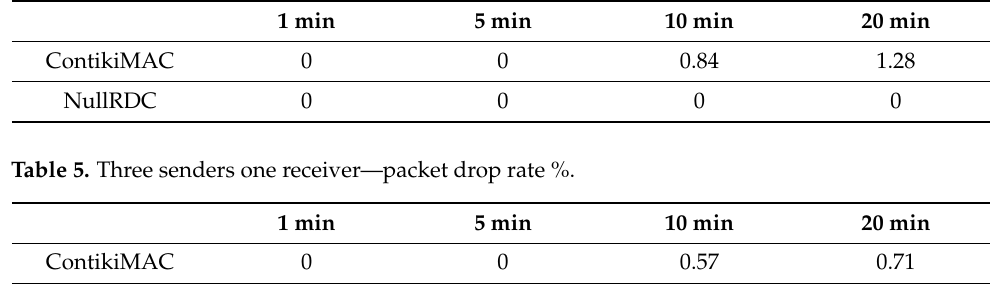
Table 4. Two senders one receiver—packet drop rate %.